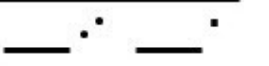
Fig. 1 – F0 movement in the head of an intonational phrase of the IE